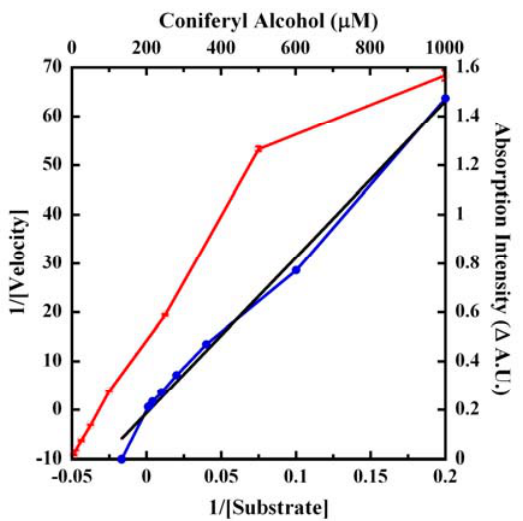
1.0 μ g/mL laccase for 30 minutes at 25 °C and the absorption at 260 nm was monitored. The open circles (red tracing) represents the Δ A.U. of (B − S) (right ordinate) plotted as a function of CA concentrations (top abscissa). The Lineweaver-Burk transformation of this data is shown as the blue tracing (closed circles) corresponding to the lower abscissa (1/Substrate) and the left ordinate (1/Velocity). The linear curve fit (black tracing) of the transformation is shown along the same axes and the r 2 was